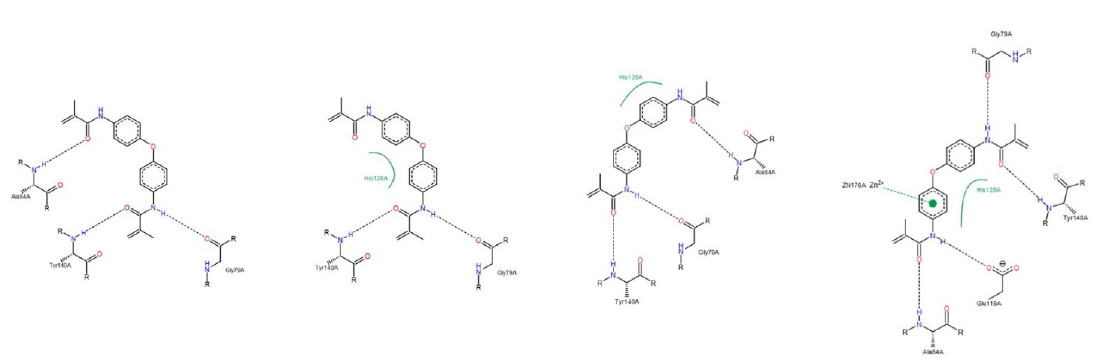
Figure A16. Interactions between compound C and MMP-1, by PoseView calculations.